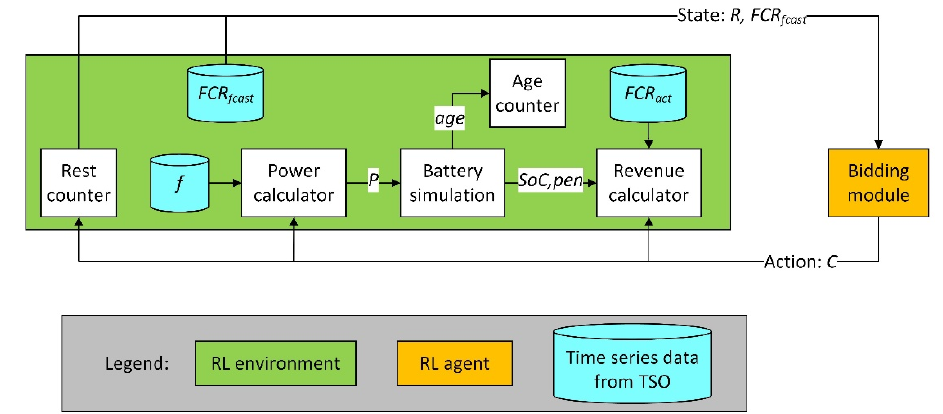
Figure 2. Architecture for performance evaluation of the trained RL agent.